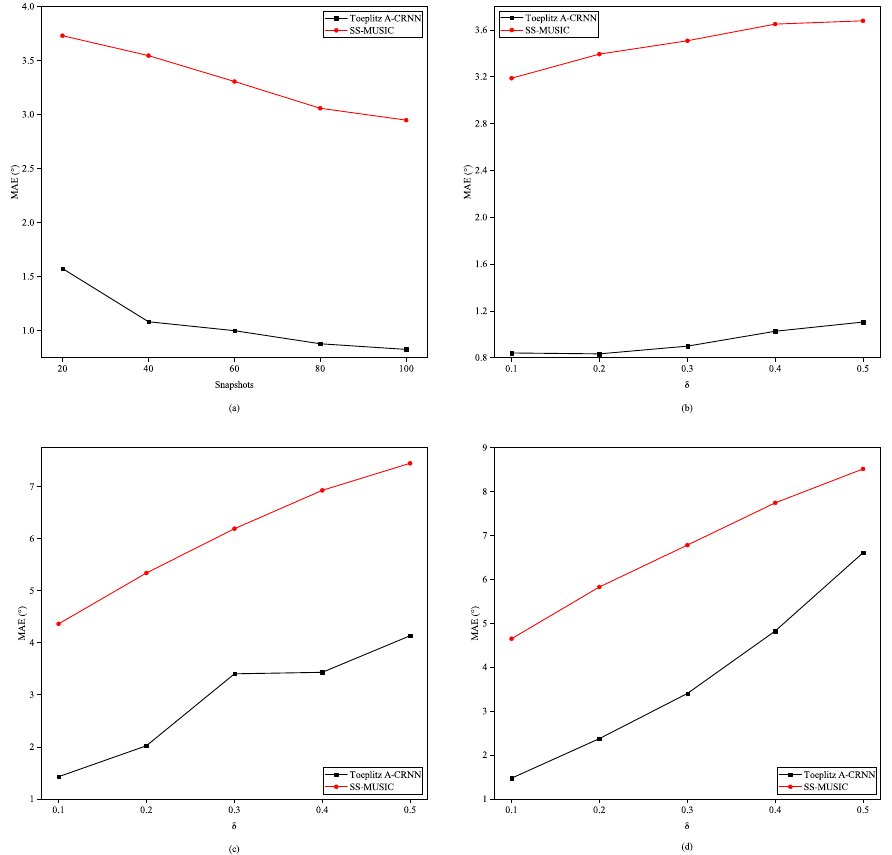
Figure 9. Performances of DOA estimation under imperfect circumstances with the SNR of testing data fixed at 20 dB: ( a ) different numbers of snapshots. ( b ) Sensor-gain inconsistence. ( c ) Combined gain inconsistence with biased sensor position. ( d ) Coexisting of gain inconsistence, position bias, and inter-sensor mutual coupling.